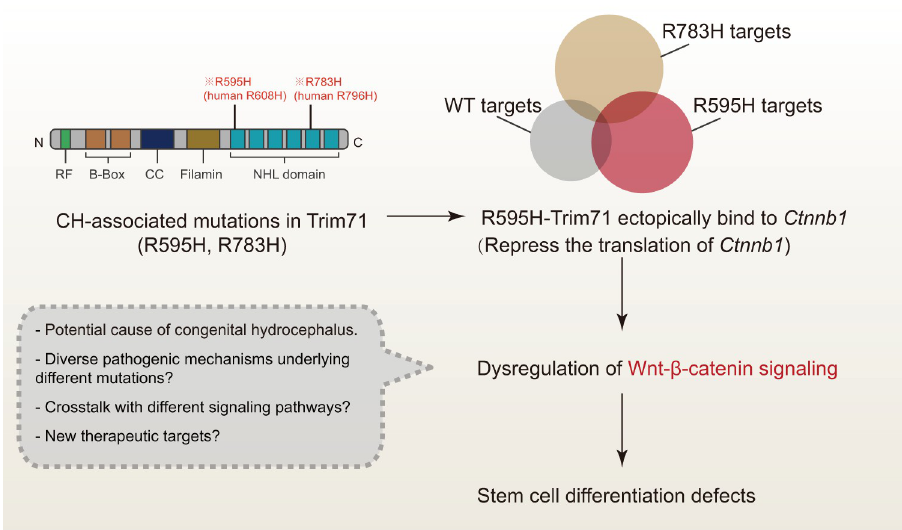
Fig 1. Potential pathological mechanisms of congenital hydrocephalus associated with Trim71 mutations. Mutations discovered in Trim71 (R595H and R783H) are located in the NHL domain. Mutant forms of Trim71 ectopically bind to distinct repertoires of target mRNAs. The ectopic binding to Ctnnb1 transcripts repressed translation and production of β -catenin. Dysregulation of Wnt– β -catenin signaling may affect stem cell neural differentiation, which could potentially cause congenital hydrocephalus. CC, coiled coil; RF, ring finger; WT, wild- type.